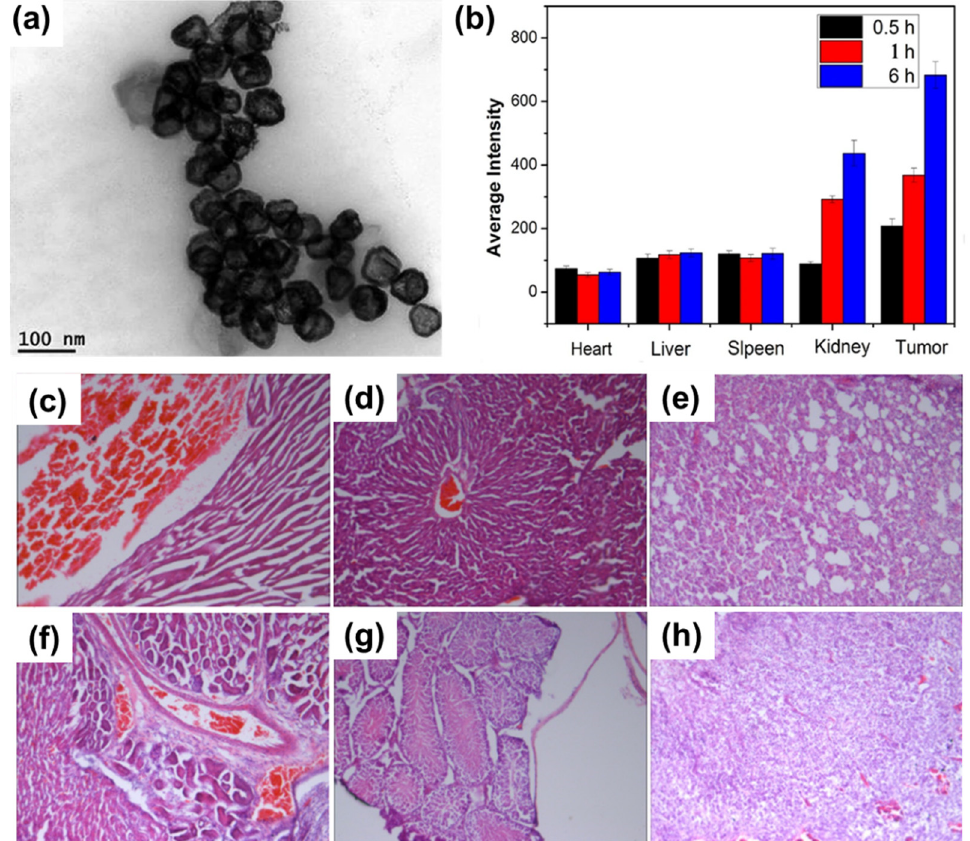
Figure 32. ( a ) TEM image of F-AuNC@Fe 3 O 4 . ( b ) Average Hounsfield unit (HU) intensity in the heart, liver, spleen, kidney, and tumor after intravenous injection. H&E staining of organ sections: ( c ) heart, ( d ) liver, ( e ) lung, ( f ) kidney, ( g ) bladder, and ( h ) tumors harvested from mice at 6 h postinjection. Adapted with permission from [141].